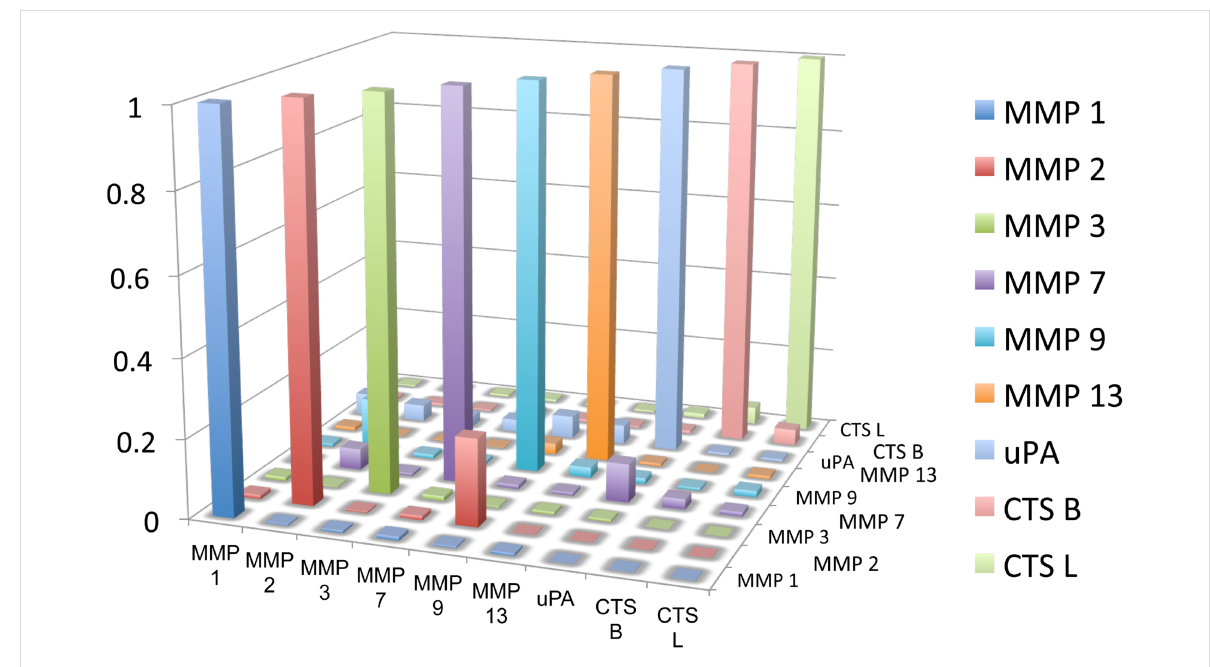
Figure 6: Cross-sensitivities of the nanoplatforms used in this study. Further explanations are provided above.